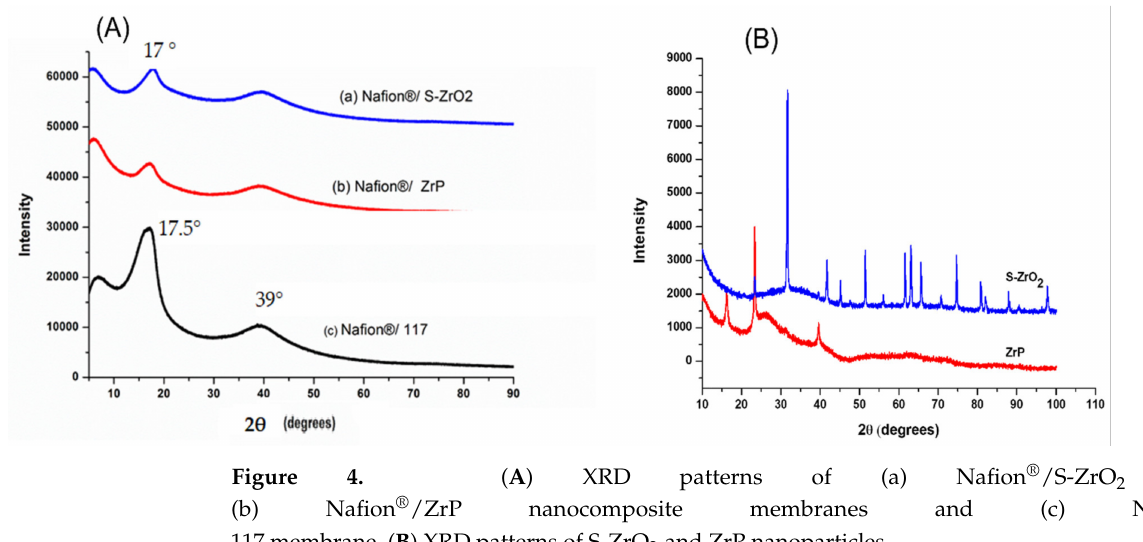
Figure 4. ( A ) XRD patterns of (a) Nafion ® /S-ZrO 2 and (b) Nafion ® /ZrP nanocomposite membranes and (c) Nafion ® 117 membrane, ( B ) XRD patterns of S-ZrO 2 and ZrP